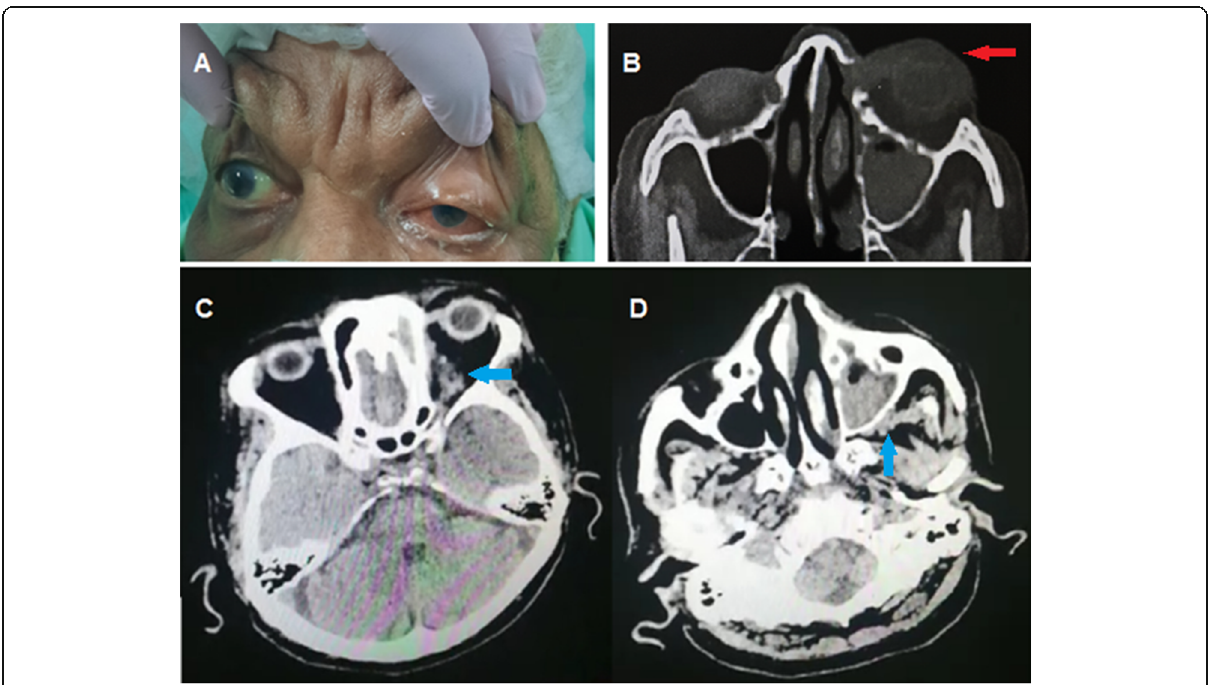
Fig. 4 A Chemosis and total ophthalmoplegia of the left eye. B Red arrow showing proptosis of the left eye along paranasal CT. C Blue arrow pointing to infiltration of soft tissue retro orbit sharing in the presentation of orbital apex syndrome donating invasion from infected and inflamed sinuses. D Blue arrow representing infiltration of periantral fat donating invasion from nearby sinuses